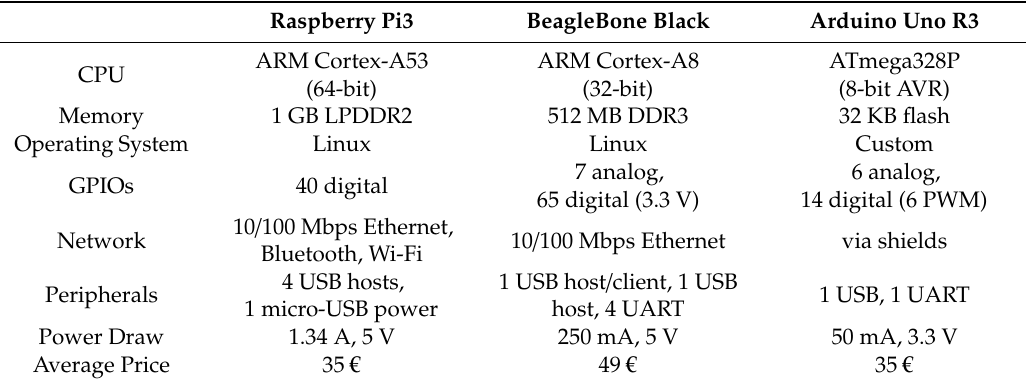
Table 1. Commonly used low-cost single board